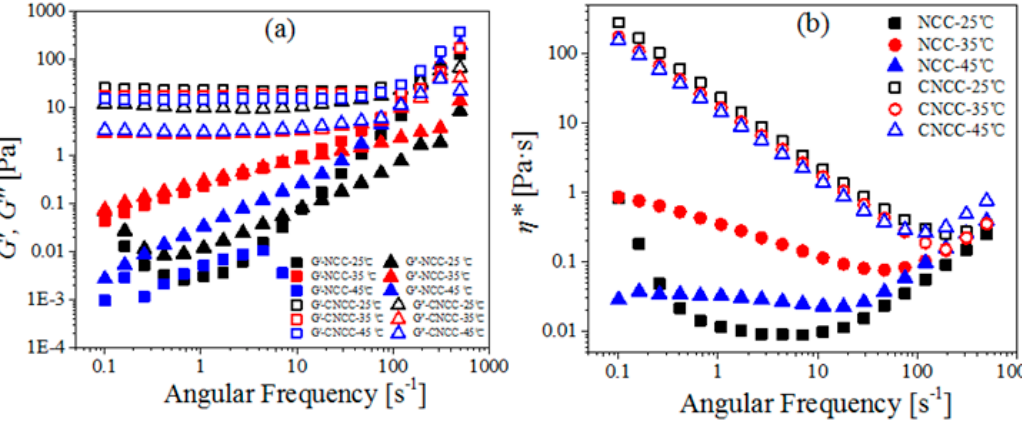
Figure 6. ( a ) Storage modulus ( G ′ ), loss modulus ( G ″ ), and ( b ) Complex viscosity ( η * ) as a function of angular frequency for the NCC and CNCC suspensions at different temperatures (25, 35, 45 °C).